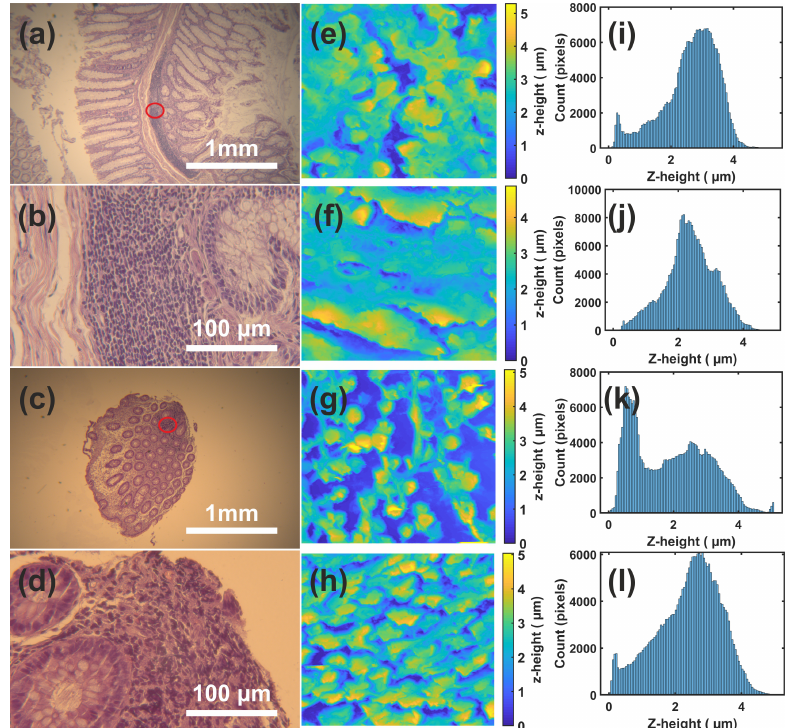
Figure 1. (a) Optical image of a M tissue in 4x lens. (b) the same as (a) for 40x magnification. (c) the lens; ( b ) the same as ( a ) for 40 magnification; Figure 1. ( a ) Optical image of an M tissue in 4 × × same as (a) for NM tissue. (d) the same as (b) for NM tissue. (e) AFM image of a tiny part (50x50 ( c ) the same as ( a ) for NM tissue; ( d ) the same as ( b ) for the NM tissue; ( e , f ) AFM images of tiny parts µ m 2 ) of M tissue displayed in (a). (f) the same as (e) for the M tissue shown in (b). (g) the same as (e) (50 50 µ m 2 ) of the M tissue displayed in ( a , b ). ( g , h ) AFM images of tiny parts (50 50 µ m 2 ) of the × × for the NM tissue displayed in (c). (h) the same as (g) for the NM tissue shown in (d). (i) histogram of NM tissue displayed in ( c , d ); ( i ) histogram of AFM tip elevation (z heights) illustrated in ( e ); and ( j – l ) AFM tip elevation (z-heights) illustrated in (e). (j), (k) and (l) the same as (i) for (f), (g) and (h). Of the same as ( i ) for ( f – h ). Notice that, magnification 4 provides an analysis of 1920 1200 pixels (an × × note, magnification 4x provides an analysis of 1920 x 1200 pixels (an area of 3.2 x 2 mm 2 ), and 40x area of 3.2 2 mm 2 ), and 40 magnification provides the same analysis for an area of 320 200 µ m 2 . × × × Of note, the visual similarity of the AFM images ( e , f ), the M sample, which, however, lead to different histogram